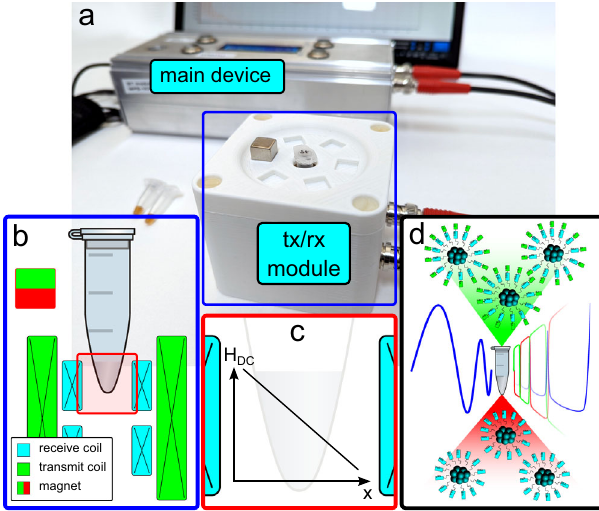
Fig. 4 | Mobile COMPASS device. a Shows the main device consisting of all necessary hardware components such as a microcontroller, ampli fi er, and fi lters, the transmit/receive module for 0.5ml Eppicaps. b A closer look at the coil design within the tx/rx module indicates the positioning of the samples within one of the gradiometric receive coils. c , d The offset magnetic fi eld H DC along the sensitive area within the rxcoil shows a strong gradient G , which hasa massive in fl uence on